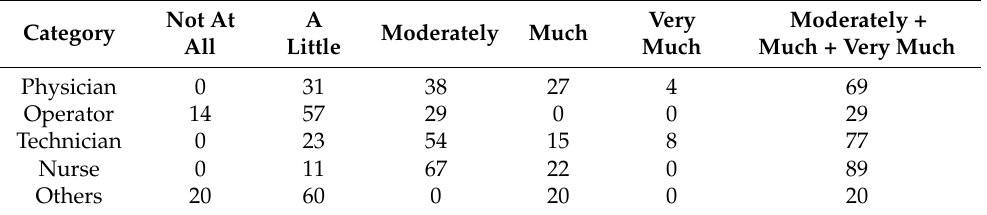
Table 6. Percentage of responses to the question: “How much does the noise affect your concen ‐ tration?”. Table 5. Percentage of responses to the question: “Usually how noisy is your working environment?”.